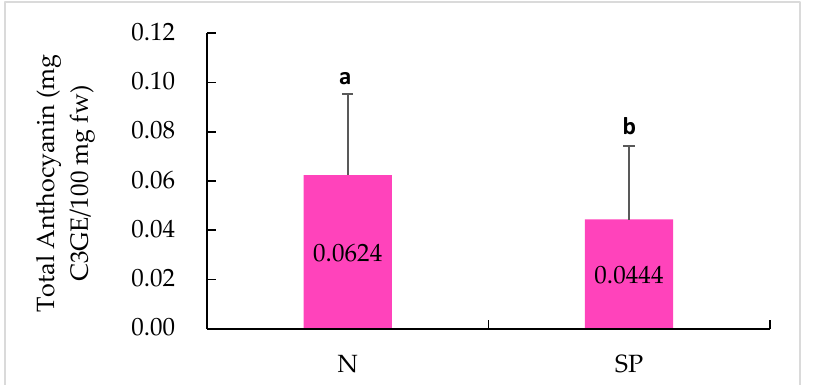
Figure 7. Comparisons of total anthocyanin contents between normal (N) and silver patch (SP) skins in all samples from 2020 and 2021. Means that do not share a common letter are significantly different at p = 0.05.